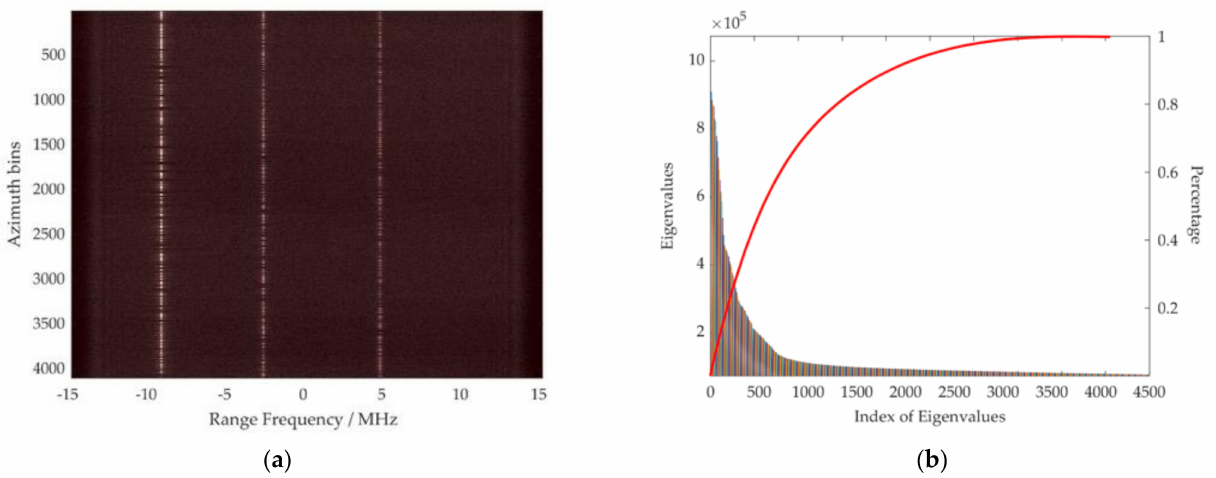
Figure 3. Structural analysis of RFI in the range-frequency domain. ( a ) Spectrogram of SAR echoes contaminated by RFI. ( b ) Eigenvalue sequences and analysis corresponding to ( a